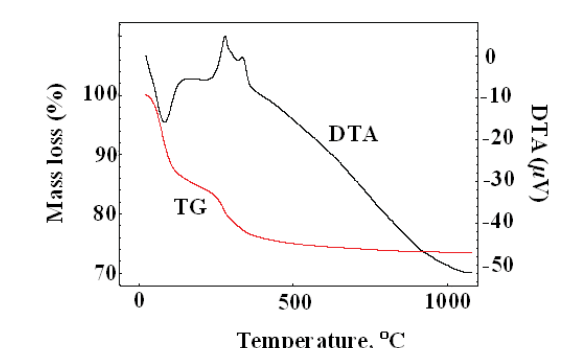
Figure 1. DTA-TG curves in air, at heating rate of 10ºC min -1 , for the as prepared sample using citric acid based sol-gel method.